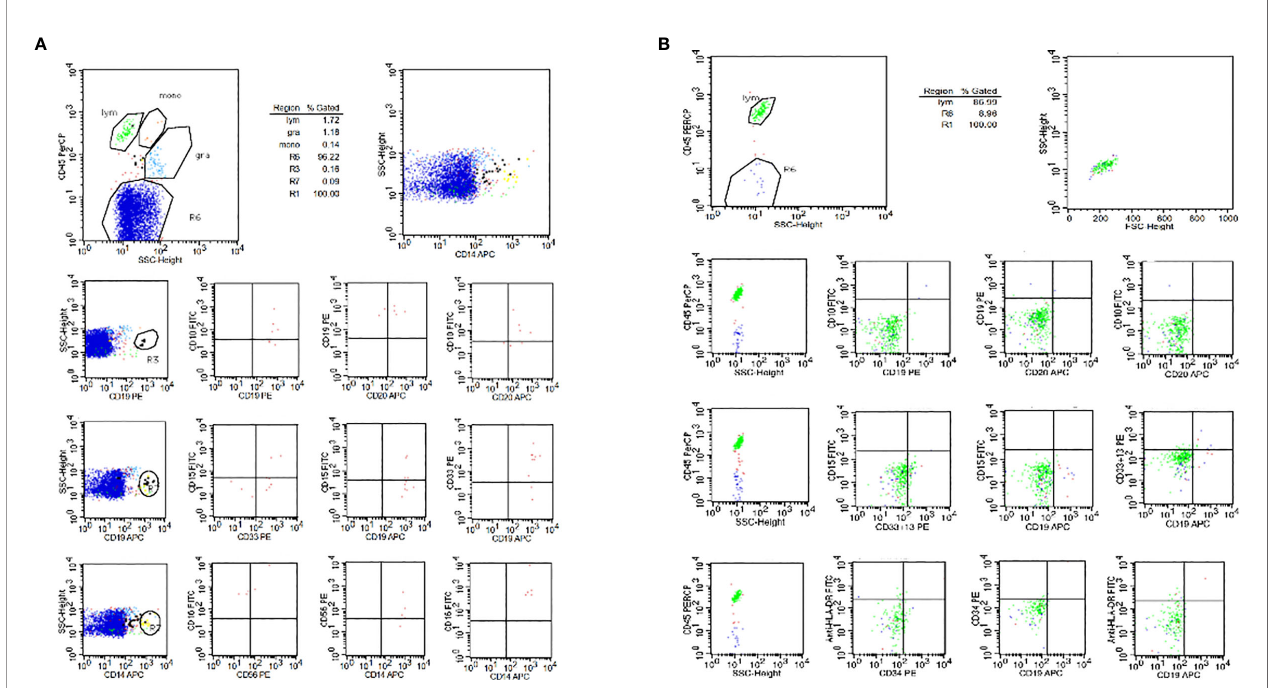
FIGURE 3 | The result of cerebrospinal fl uid fl ow cytometry. (A) The result of cerebrospinal fl uid fl ow cytometry before CAR-T treatment, 0.16% malignant lymphocytes detected in CSF. (B) The result of cerebrospinal fl uid fl ow cytometry after CAR-T treatment, no leukemic cells detected in CSF.